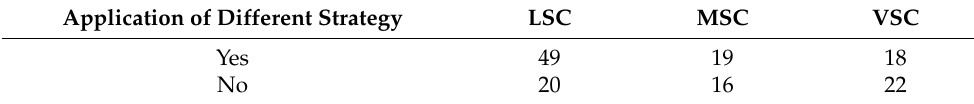
Table 2. Influence of estimated value of procurement on bid price